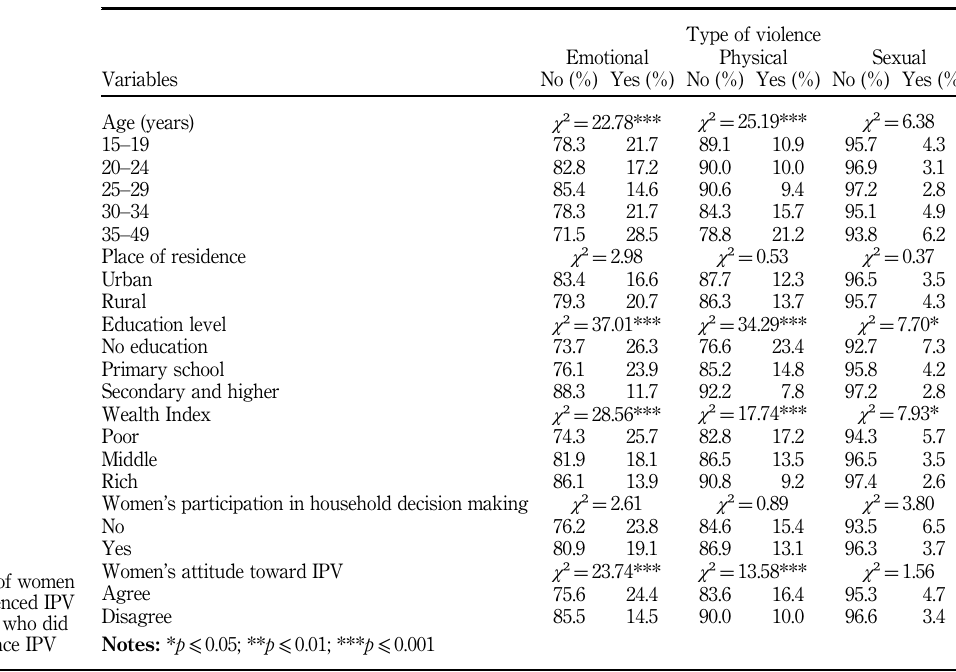
Table II. Prevalence of women who experienced IPV and women who did not experience